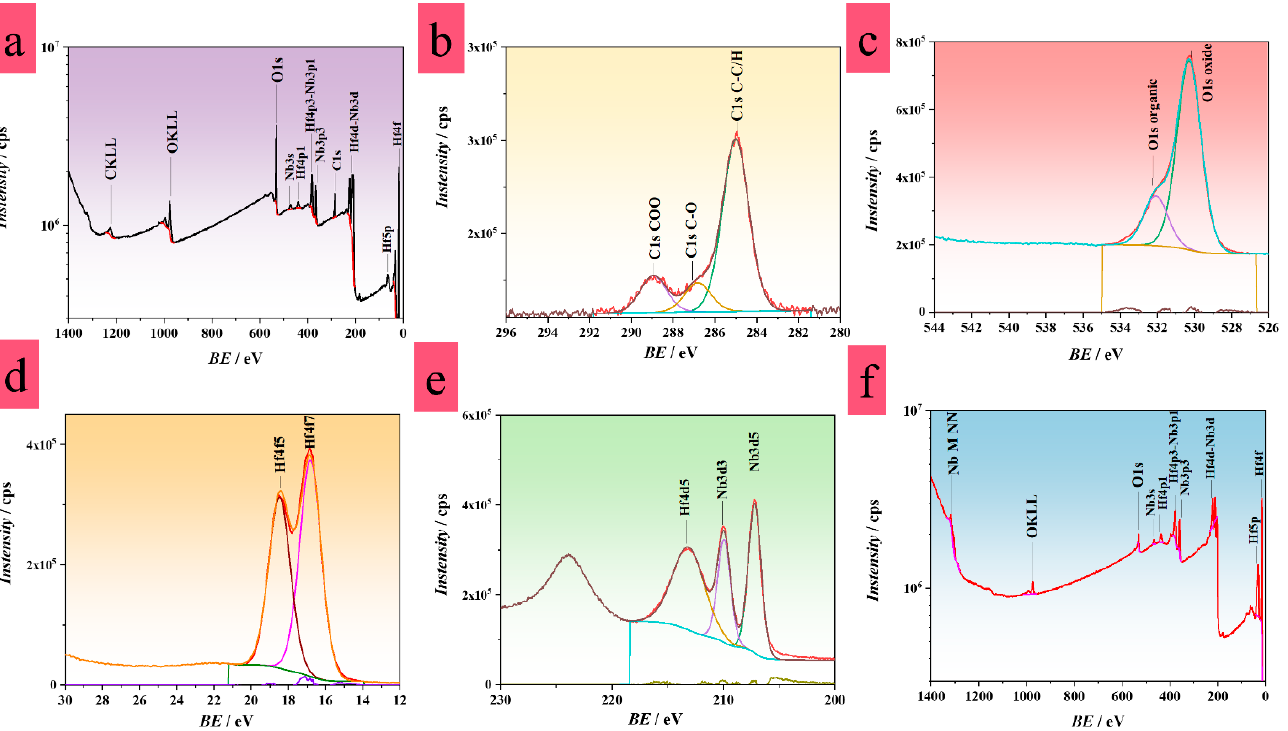
Figure 2. ( a , f ) XPS survey and ( b – e ) high-resolution spectra of Hf-45 at.% Nb samples prepared in CB.